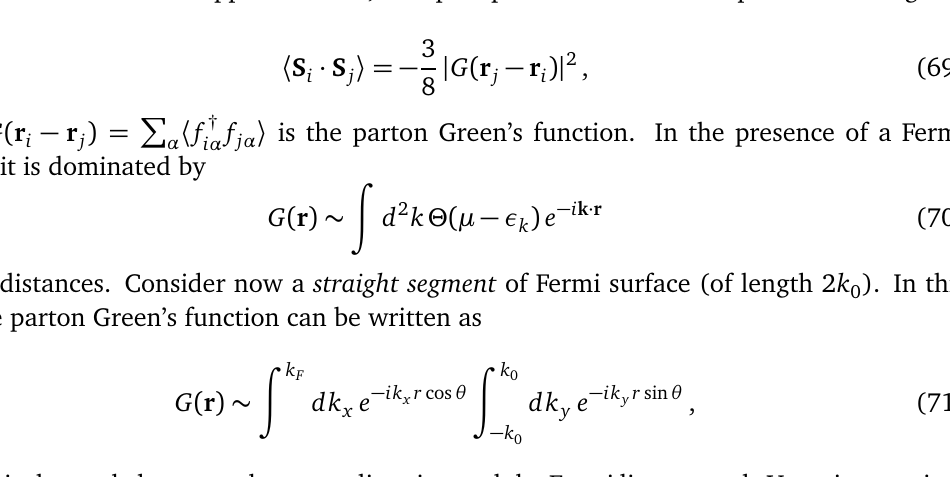
Figure 4: Contour plot of the spectra E Table IX of Ref. [ 45 ] . The used hopping parameters are it relates the third band to the first one as E dashed straight